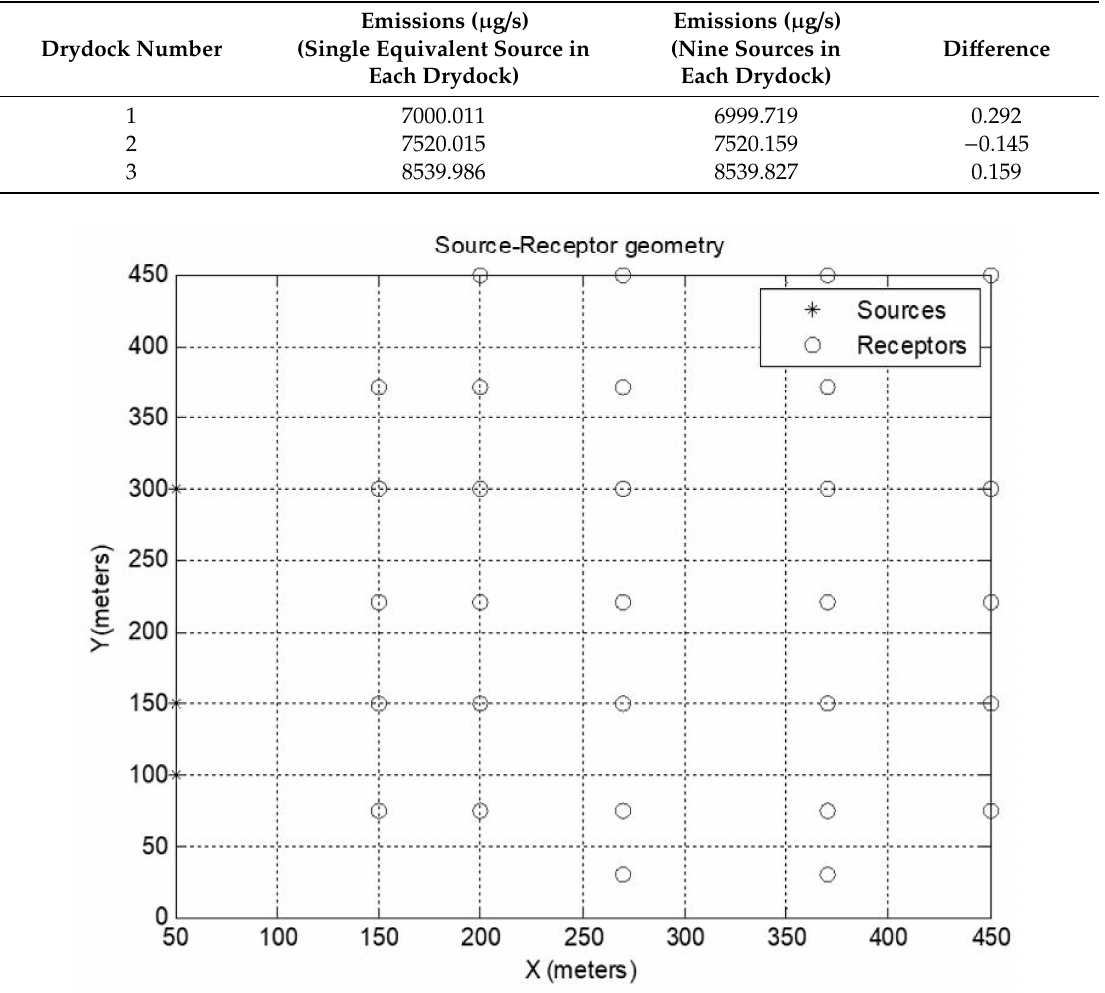
Table 7. Comparison of total emissions at each drydock (single equivalent source vs. nine sources in each drydock).